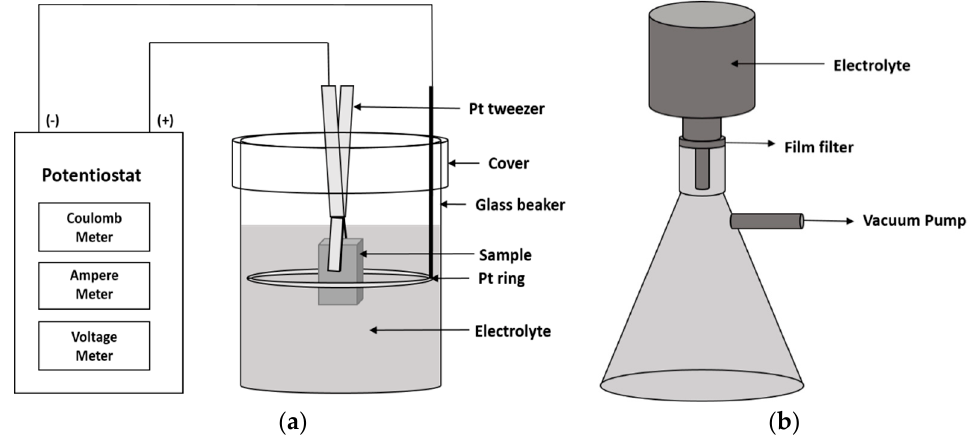
Figure 1. Experimental setup for electrolytic extraction ( a ) and filtration ( b